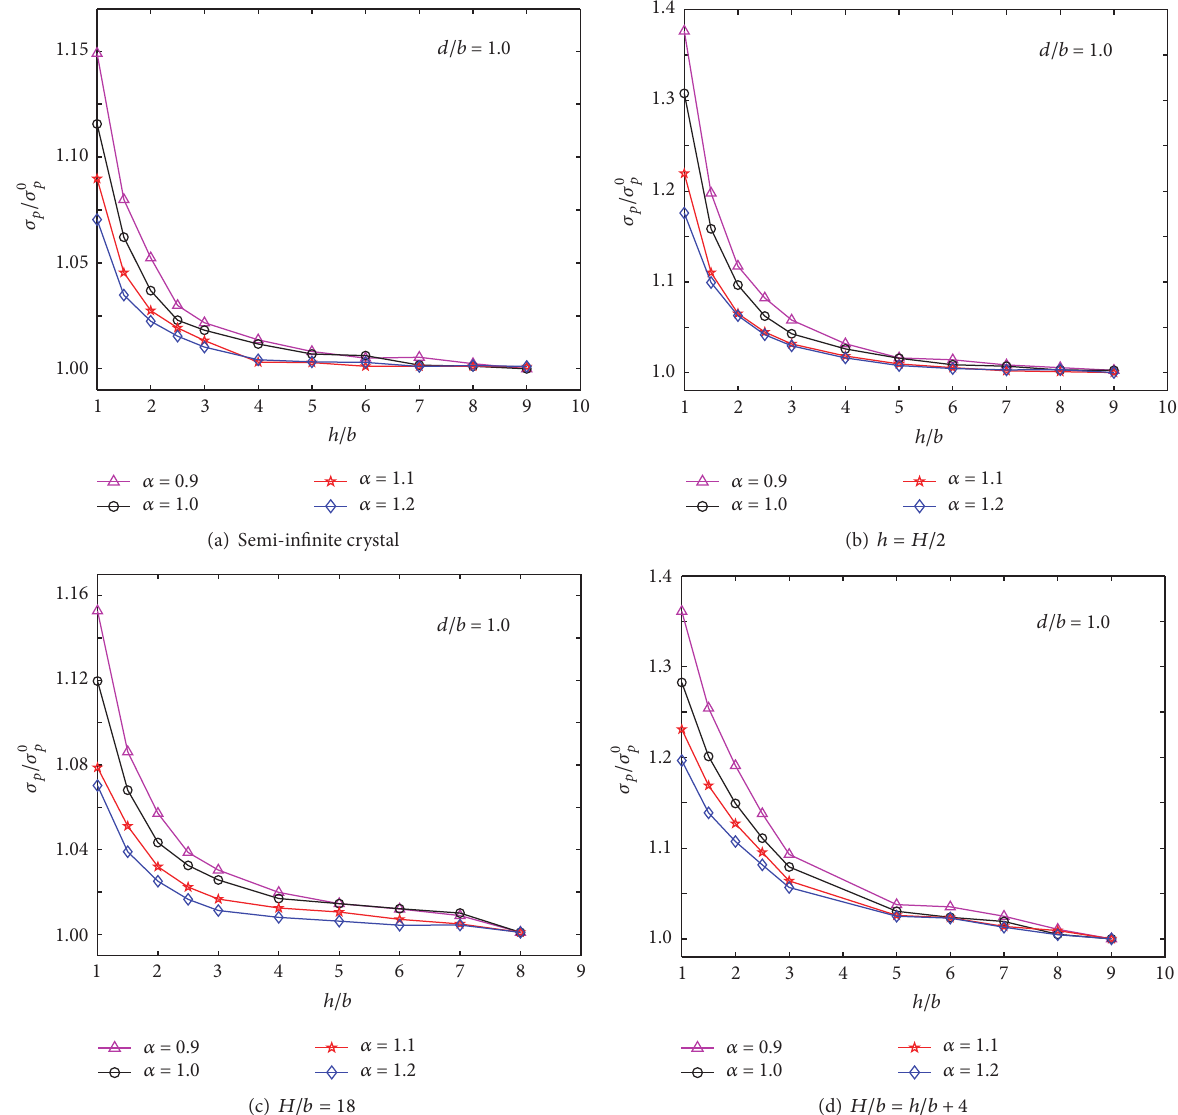
Figure 4: Variation of the amplification factors of Peierls stress for a screw dislocation with respect to its distance to the surface for various normalized unstable stacking fault energy.